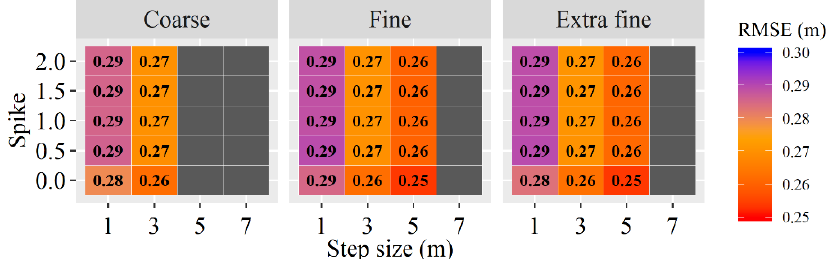
Figure 2. Root mean square error (RMSE) values of the digital terrain models (DTMs) derived from the calibration of the parameters of the progressive triangulated irregular network (PTIN). Grey tiles represent settings that produced eroded DTMs.